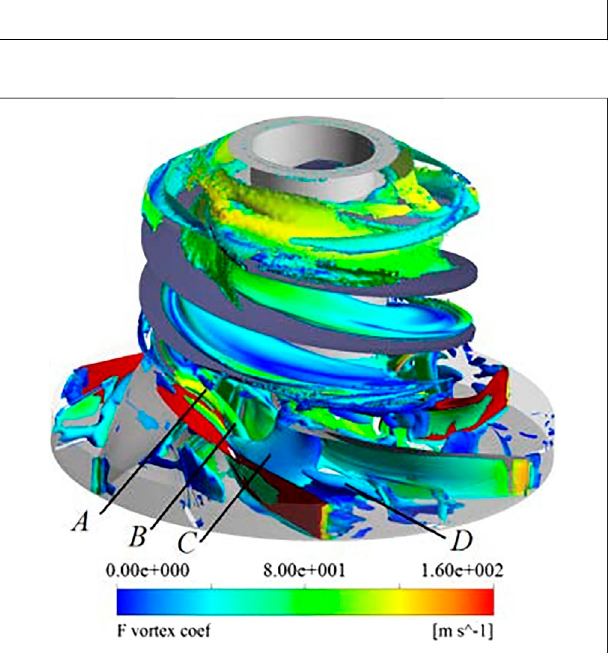
FIGURE 1 | Power system (2011).